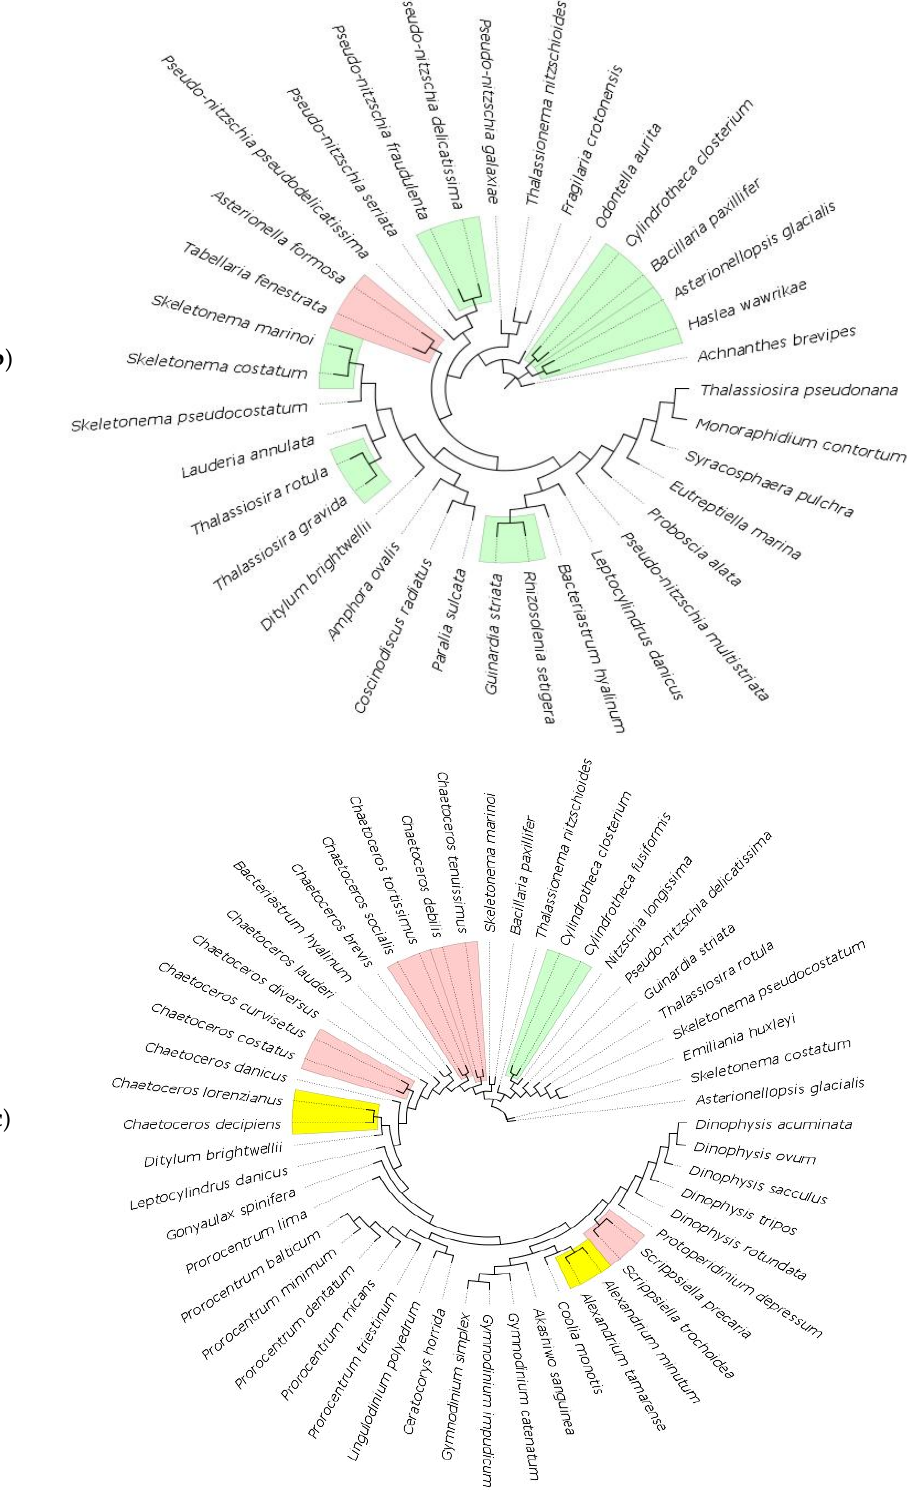
Figure 7. Maximum likelihood phylogenetic tree (GTR+I+G4 model of substitution with 100 bootstrap replicates) of marine coastal species for 18S markers ( a ), 16S marker ( b ) and COI marker ( c ). Colored branches indicate species that cluster together under bPTP analysis, with green representing Bayesian support (BS) values of 0.3 or below, yellow for BS 0.3–0.5, red for BS 0.5–0.6.